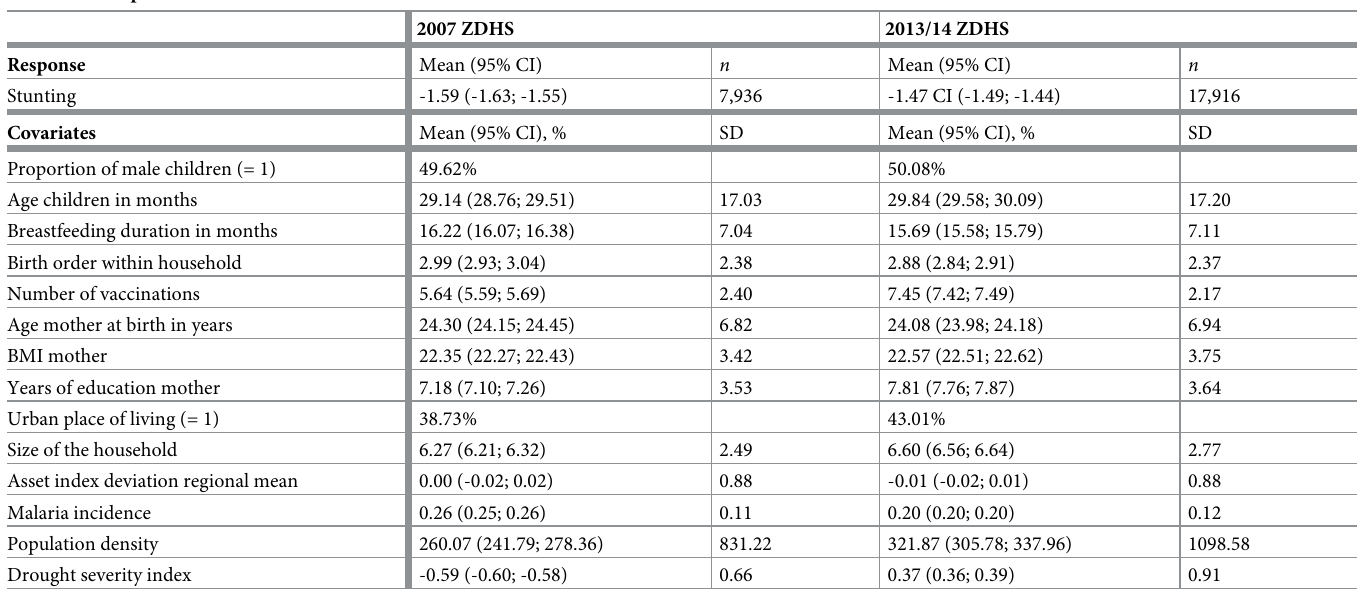
Table 5. Descriptive statistics covariates.